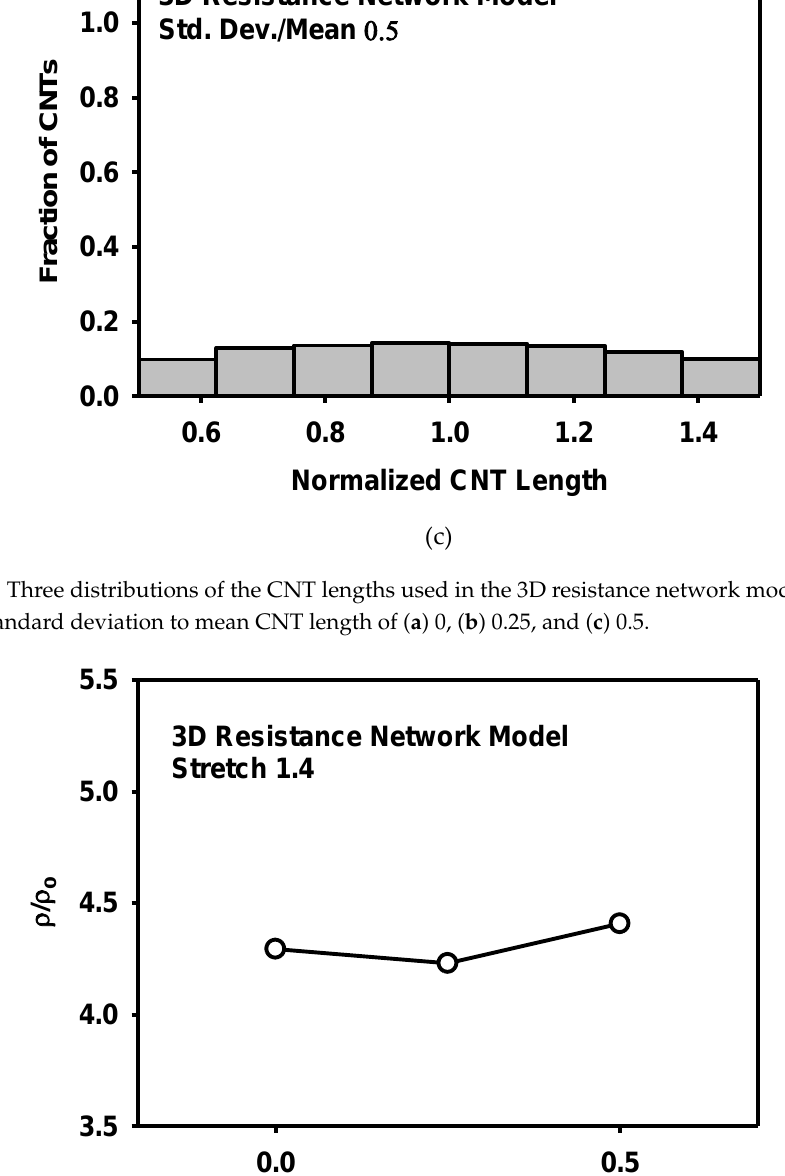
Table 3. Parameters of the continuum resistivity model